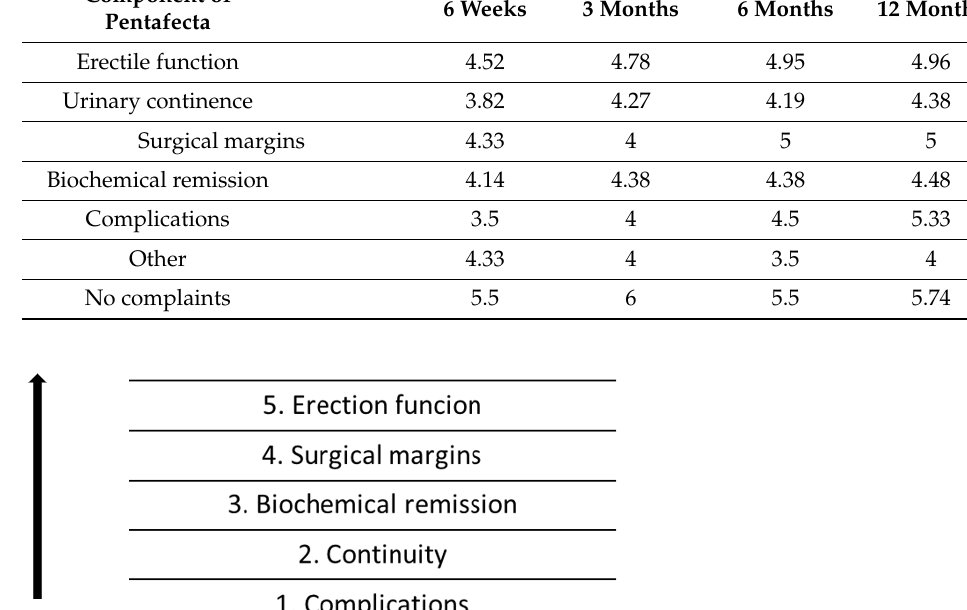
Table 4. Summary of the average declared quality of life in patients reporting the indicated ailment as dominant (scale of 1–6, Appendix A).